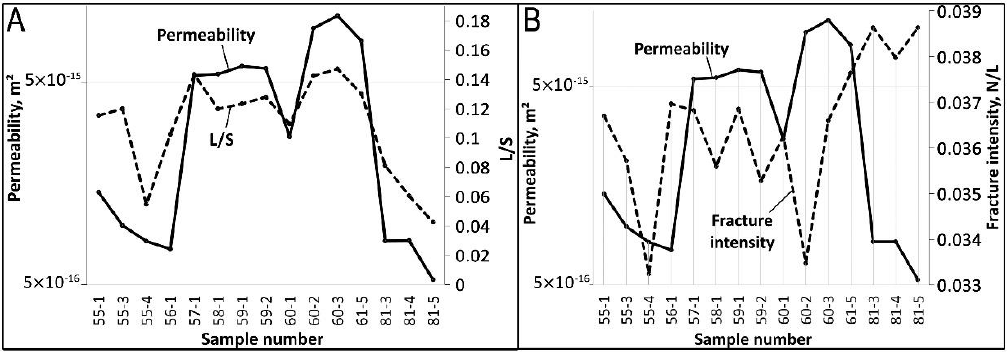
Figure 7. Graphs of the distribution of cumulative length ( A ), number of microfractures ( B ), L/S ( C ), Fracture intensity ( D ), porosity ( E ) and permeability ( F ) of microfractures in oriented thin sec- tions.